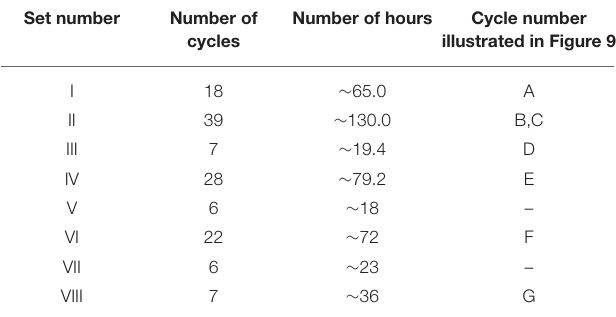
TABLE 2 | The time course of charge-discharge cycles for NDRGO-Mo-Li-2S at 0.2mA in the potential window, + 1V to − 0.5V. Set number Number of Number of hours Cycle number cycles illustrated in Figure